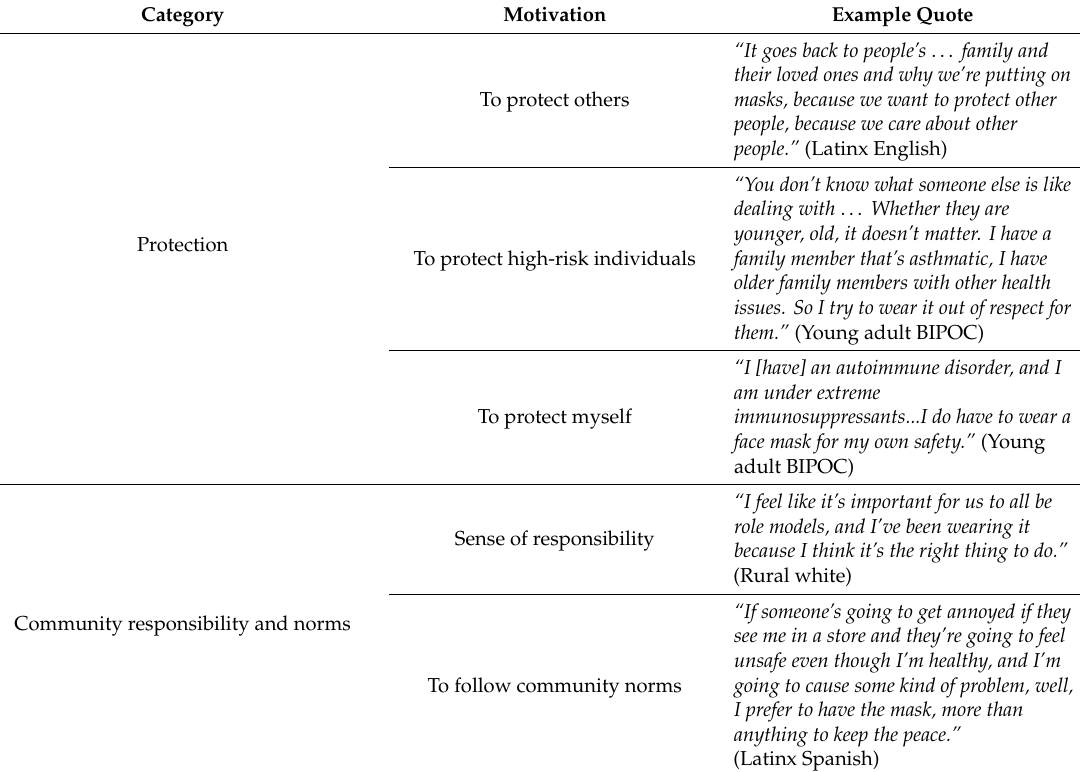
Table 2. Motivations for the use of face coverings among North Carolina